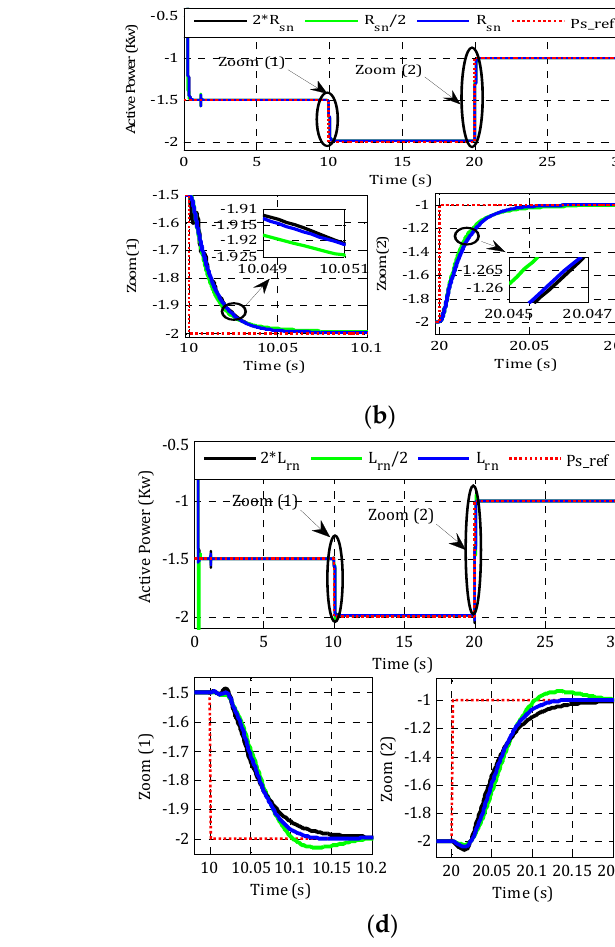
many works done under similar conditions. From Table 1, it can be seen that the proposed